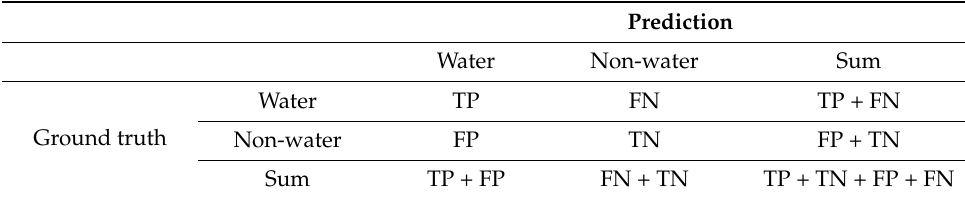
Table 1. Confusion matrix